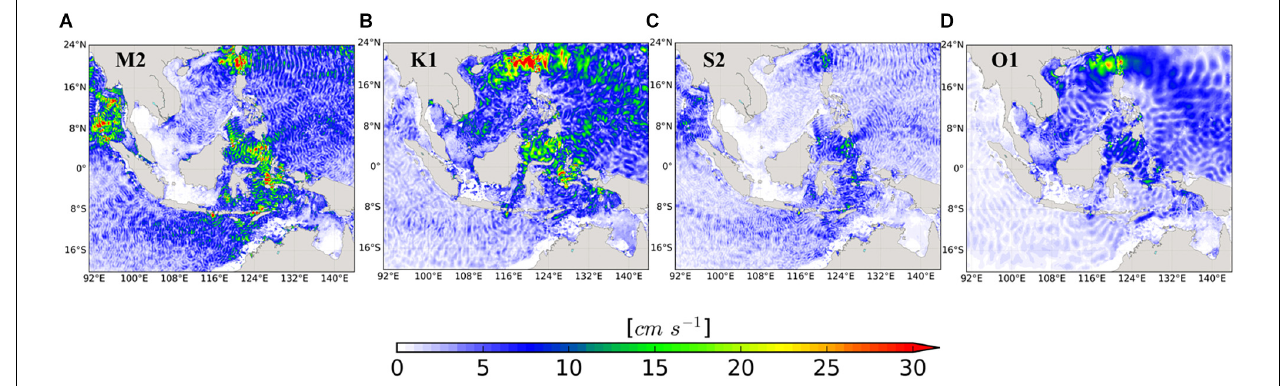
FIGURE 13 | Semi-major axis of the velocity (cm s − 1 ) for the (A) M2, (B) K1, (C) S2, and (D) O1 tidal constituents in the NEMO 1/12 ◦ INDESO model configuration (Figure from Nugroho, 2017. Permission obtained from author).